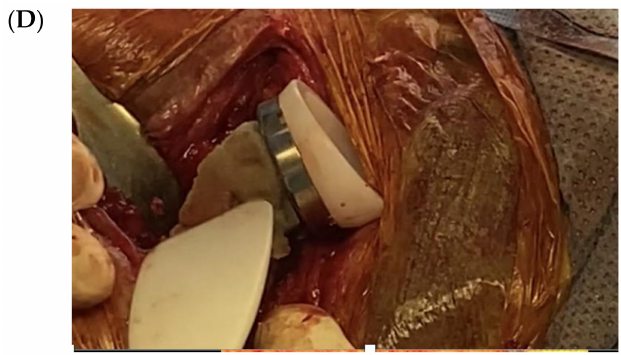
Figure 5. ( A , B ) In the second stage surgery, a femoral diaphysis tantalum cone was inserted in the proximal humerus with a cemented stem RSA. ( C , D ) Finally, bioactive glass proximal augmentation was performed.